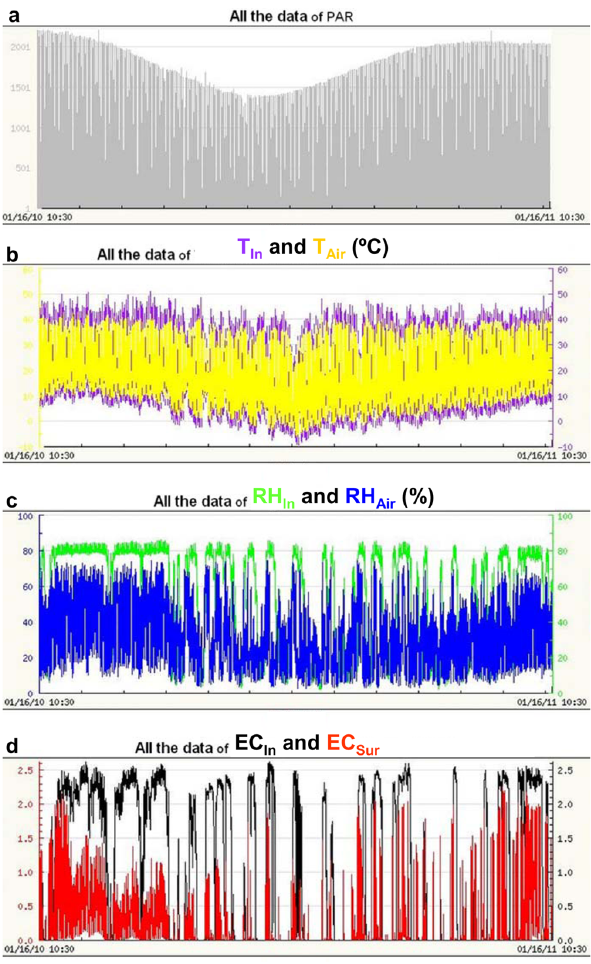
Fig. 2. Micro-environmental data collected over one year inside and outside halite pinnacles in the Yungay region. (a) Photosynthetic active radiation (PAR). (b) Temperature inside the pinnacle ( T In , purple line) and atmospheric temperature ( T Air , yellow line). Note the higher temperature amplitudes inside the pinnacle. (c) Relative humidity inside the pinnacle (RH In , green line) and air relative hu- midity (RH Air , blue line). Note the long periods when RH In was above 75% (deliquescence relative humidity), while RH Air never exceeded 75%. (d) Electrical conductivity inside the halite pinna- cle (EC In , black line) and surface electrical conductivity (EC Sur , red line). Note the long periods when EC In and also EC Sur values were above 0, indicating the presence of liquid water.